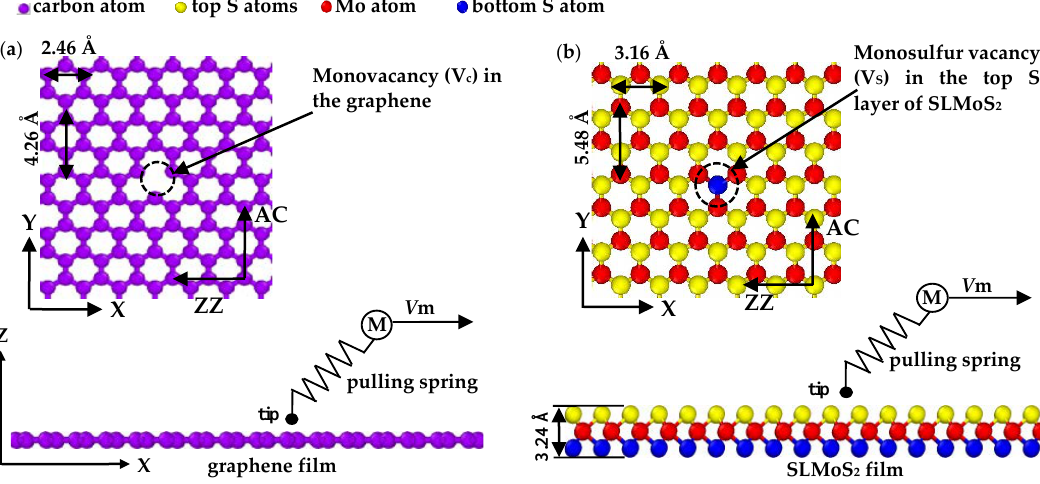
Figure 1. ( a ) The schematic diagram of the atomic-scale: the frictional interaction between a single-atom tip and the graphene with the monovacancy (Vc). ( b ) The schematic diagram of the atomic-scale: the frictional interaction between a single-atom tip and the SLMoS 2 with the monosulfur vacancy (Vs) in the top S layers. The tip is connected via a pulling spring with the elasticity of C to the body M and is moved along the X direction at a constant velocity of V m .